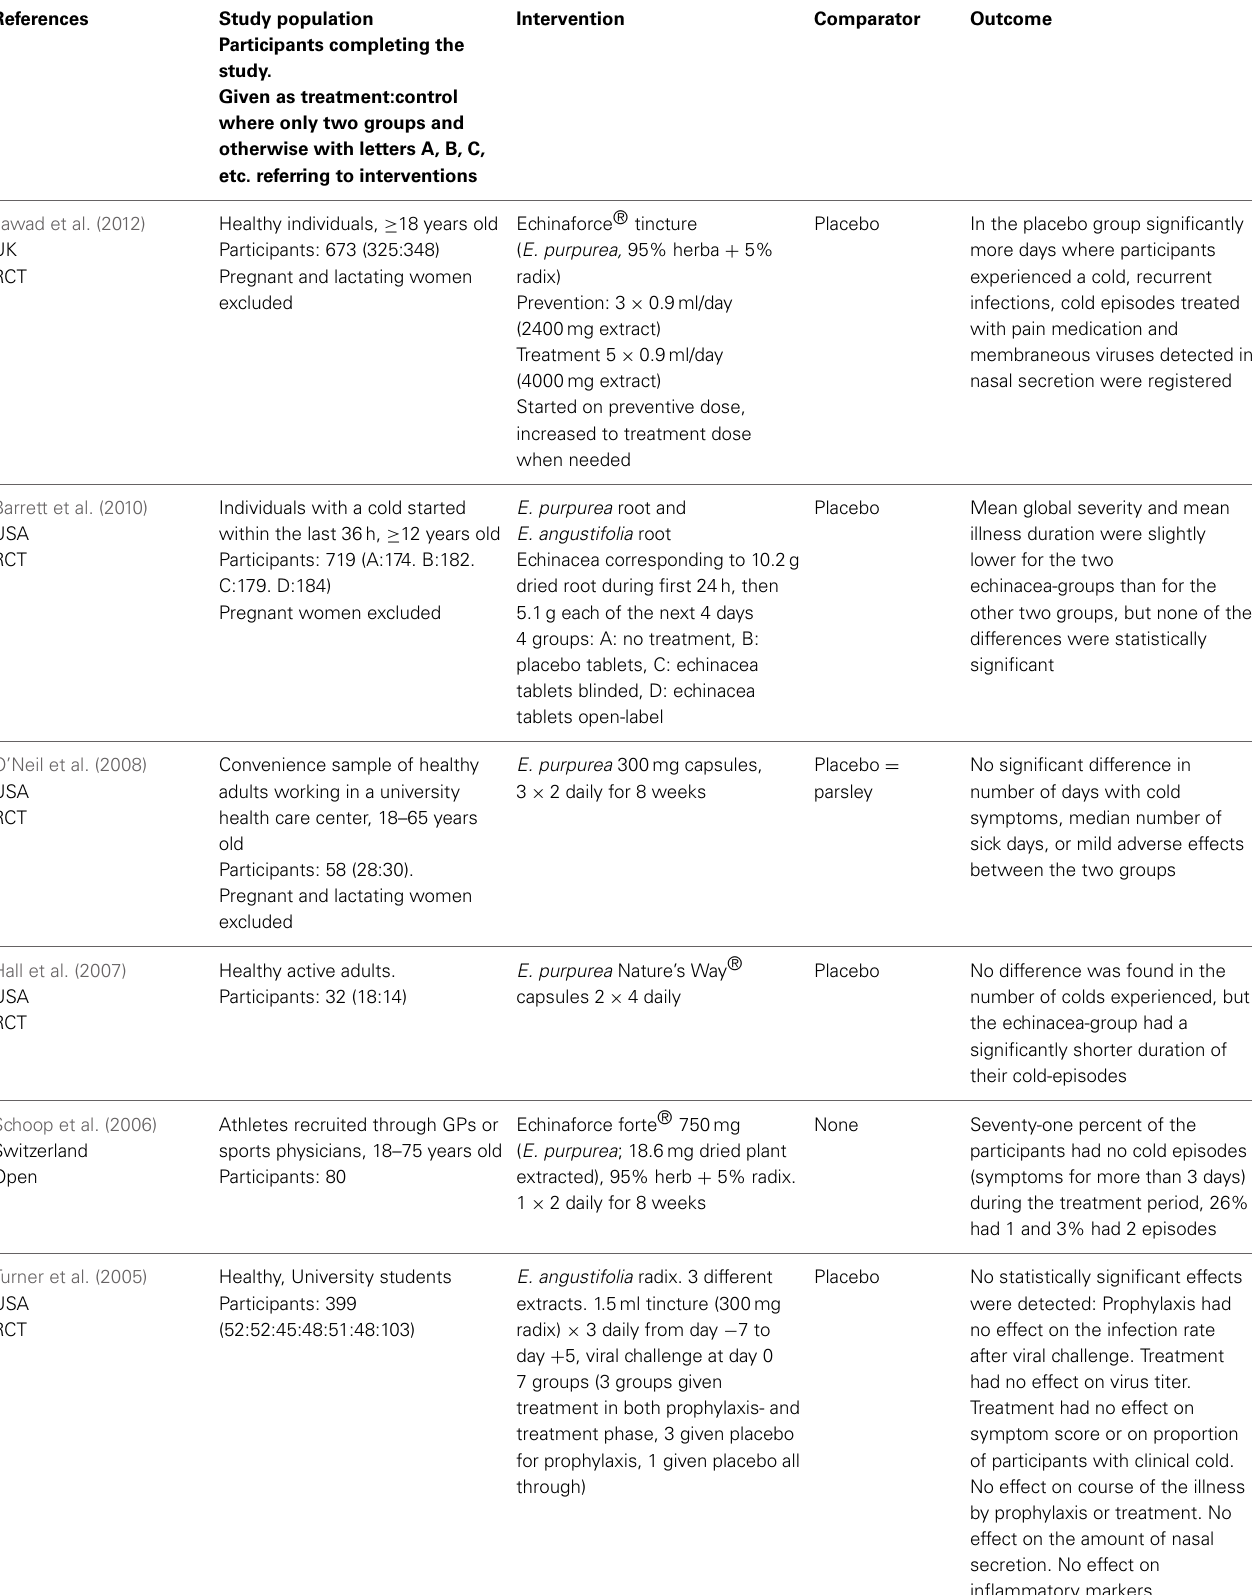
Table 2 | Clinical trials and other human studies on the efficacy of Echinacea sp. against upper respiratory tract